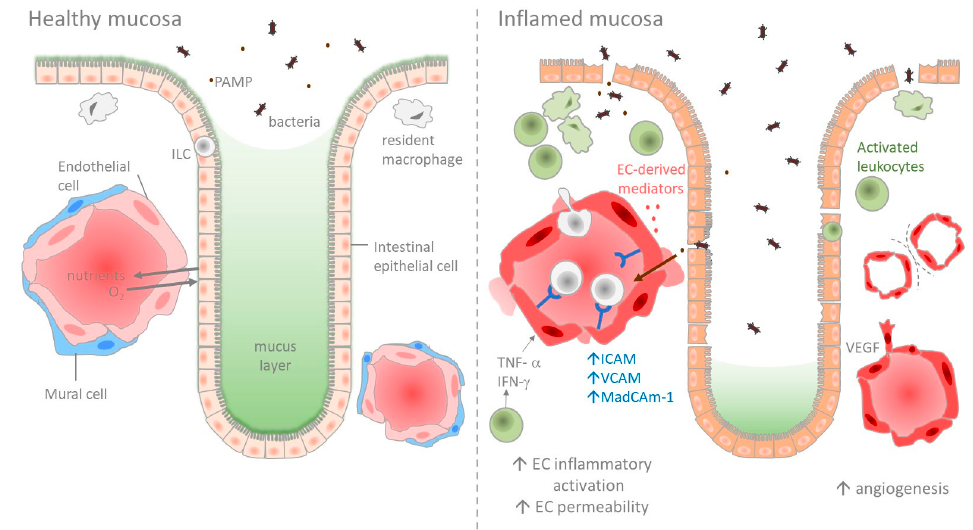
Figure 1. In the healthy intestine (depicted here, the colon mucosa), the mucosal microvasculature participates in homeostasis by regulating the absorption of essential nutrients, electrolytes, and water, while building a second barrier towards luminal microbes. During IBD, inflammation activates the intestinal microvasculature through release of cytokines and growth factors, leading to adhesion molecule expression, leukocyte extravasation, vascular hyperpermeability, and an increase in both sprouting and intussusceptive angiogenesis. Table 1. Different mesenteric vascular cell subtypes in homeostasis and in IBD.